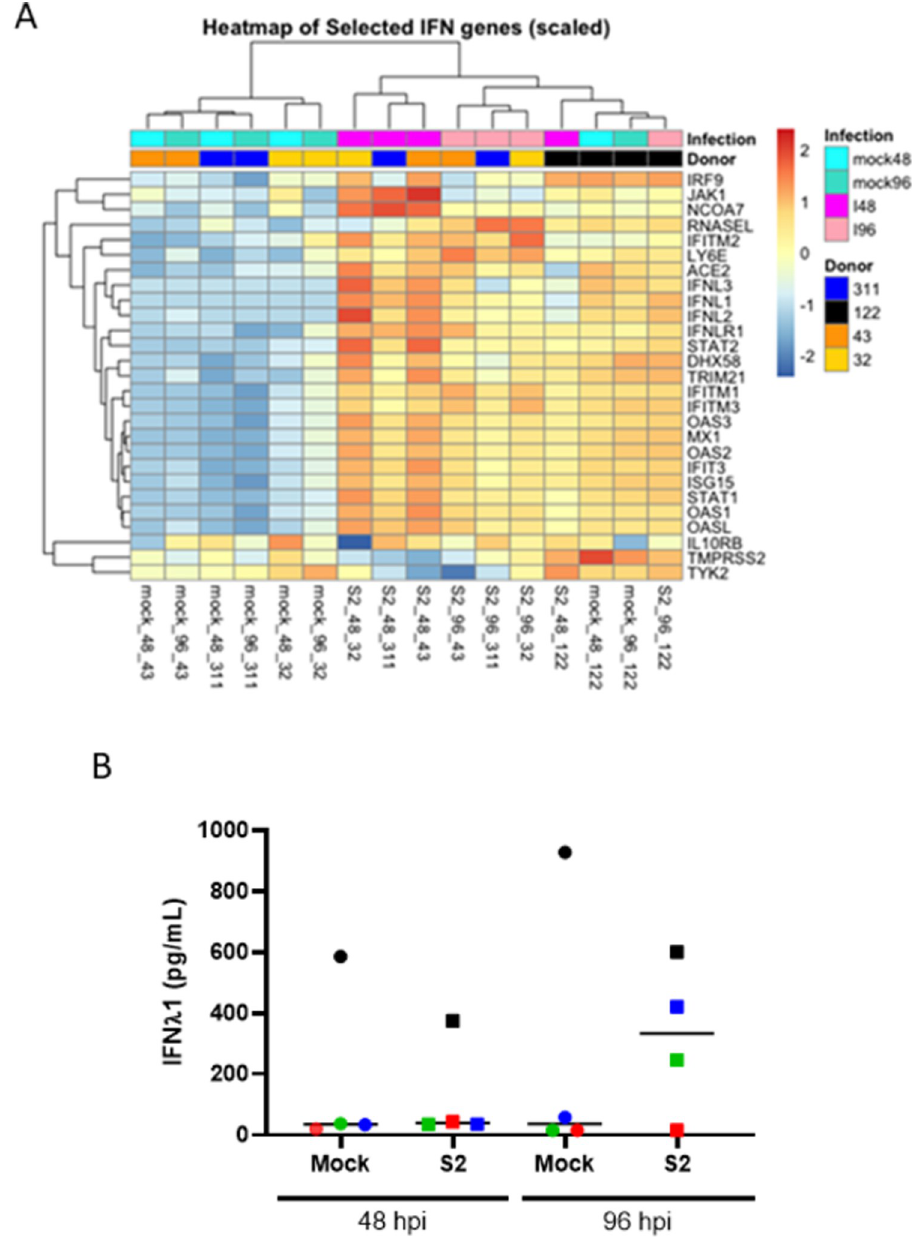
Fig 2. Transcriptomic profiles and protein quantification demonstrated a preactivated IFN response in a donor resistant to infection. WD-PNECs from 4 adult donors were infected with a clinical isolate of SARS-CoV-2 (MOI = 0.1) or mock infected. At 48 and 96 hpi RNA was extracted from the cultures and global transcriptomic analysis was performed. Selected genes, pertaining to innate immune responses to viral infection are illustrated by heatmap, gene upregulation (Red) and down regulation (blue) (A). IFN λ 1 concentration in basolateral medium from mock infected cultures and SARS-CoV-2-infected WD-PNECs at 48 and 96 hpi from 4 donors was quantified by ELISA. Each donor is represented by a different